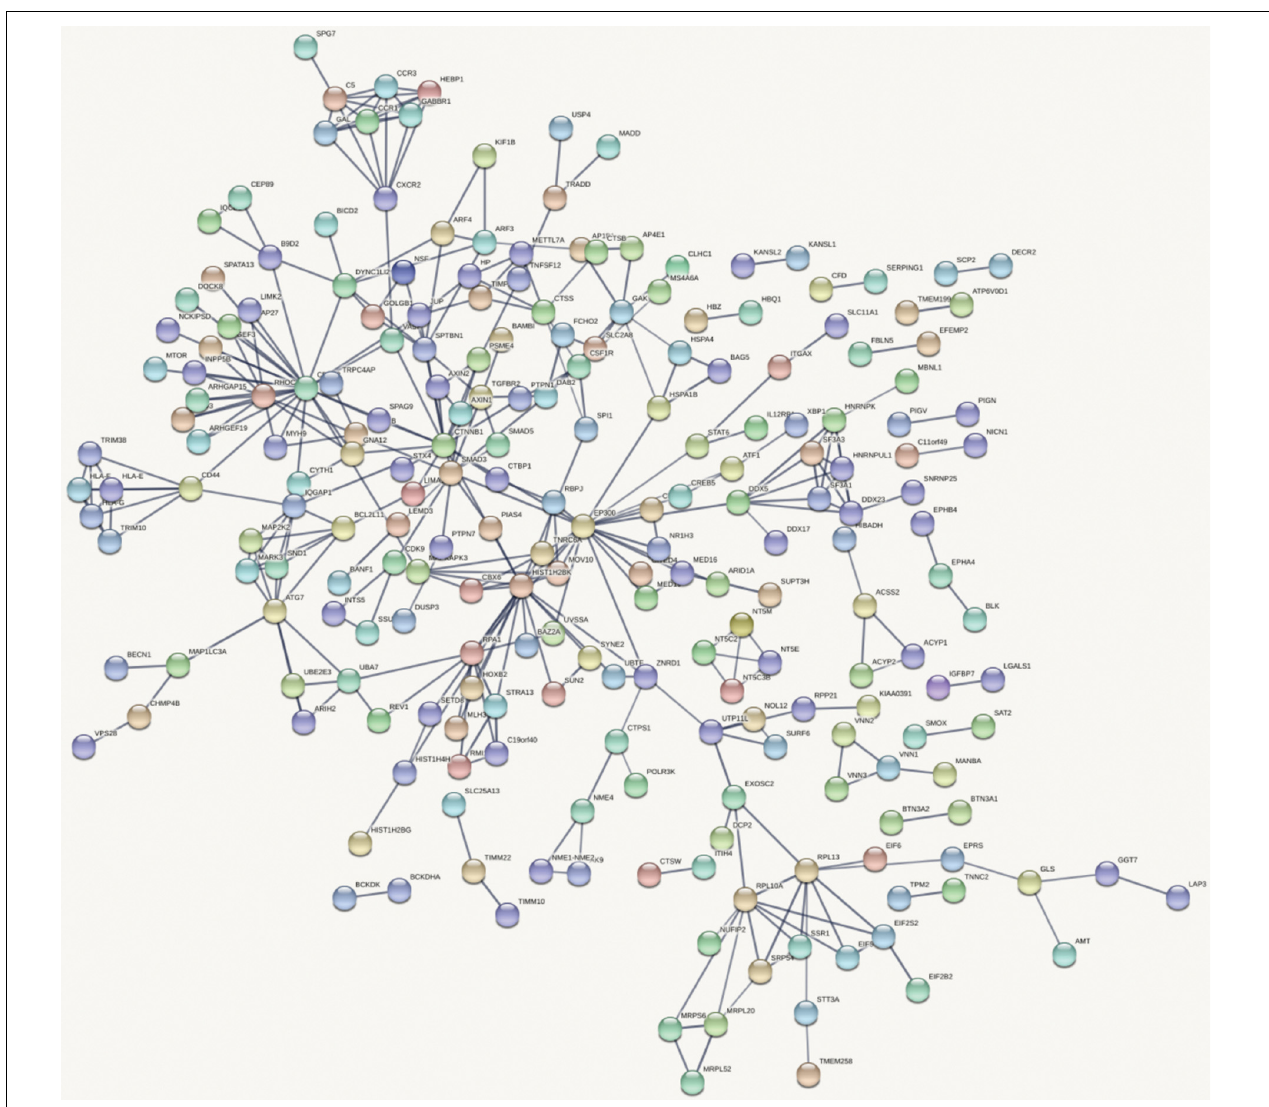
FIGURE 5 | Gene interaction network obtained from all significant